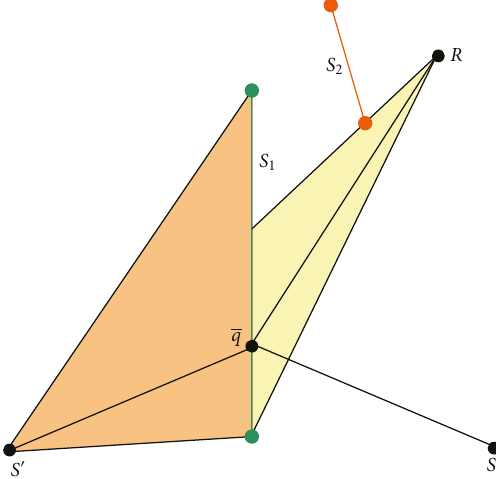
Figure 9: The real source S and the receiver R face the di ff usive reflector s 1 . Reflector s 2 partially occludes s 1 with respect to the receiver. S (cid:6) is the image-source of S mirrored over the prolongation of s 1 . The segments Sq and qR form a di ff usive